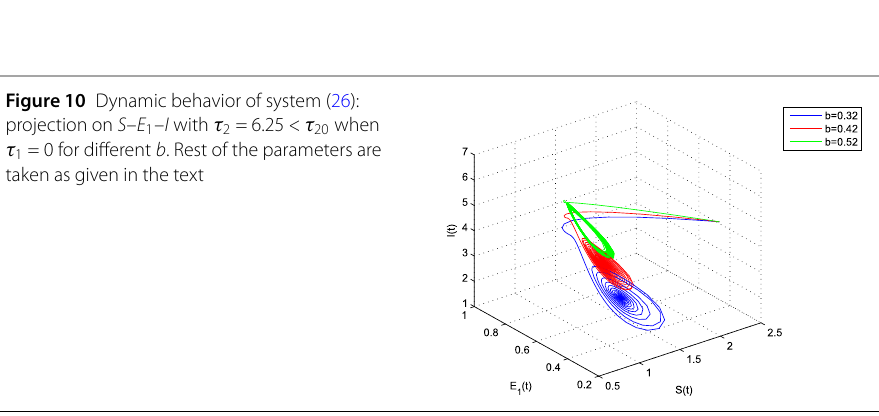
parameters: b = 0.32, β = 0.1, σ = 0.004, p = 0.4, q = 0.6, α 1 = 0.36, α 2 = 0.26, γ = 0.1.